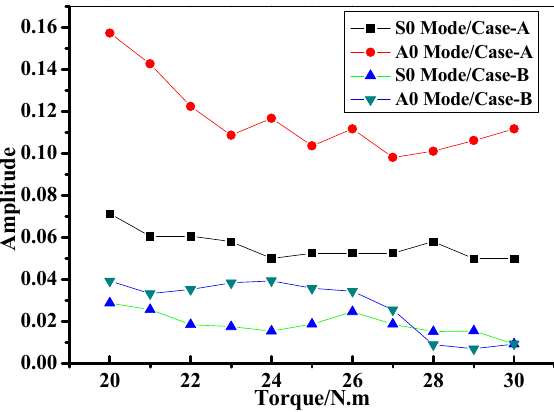
Figure 6. Amplitude of S0 and A0 mode as the function of the applied torque on the bolt.